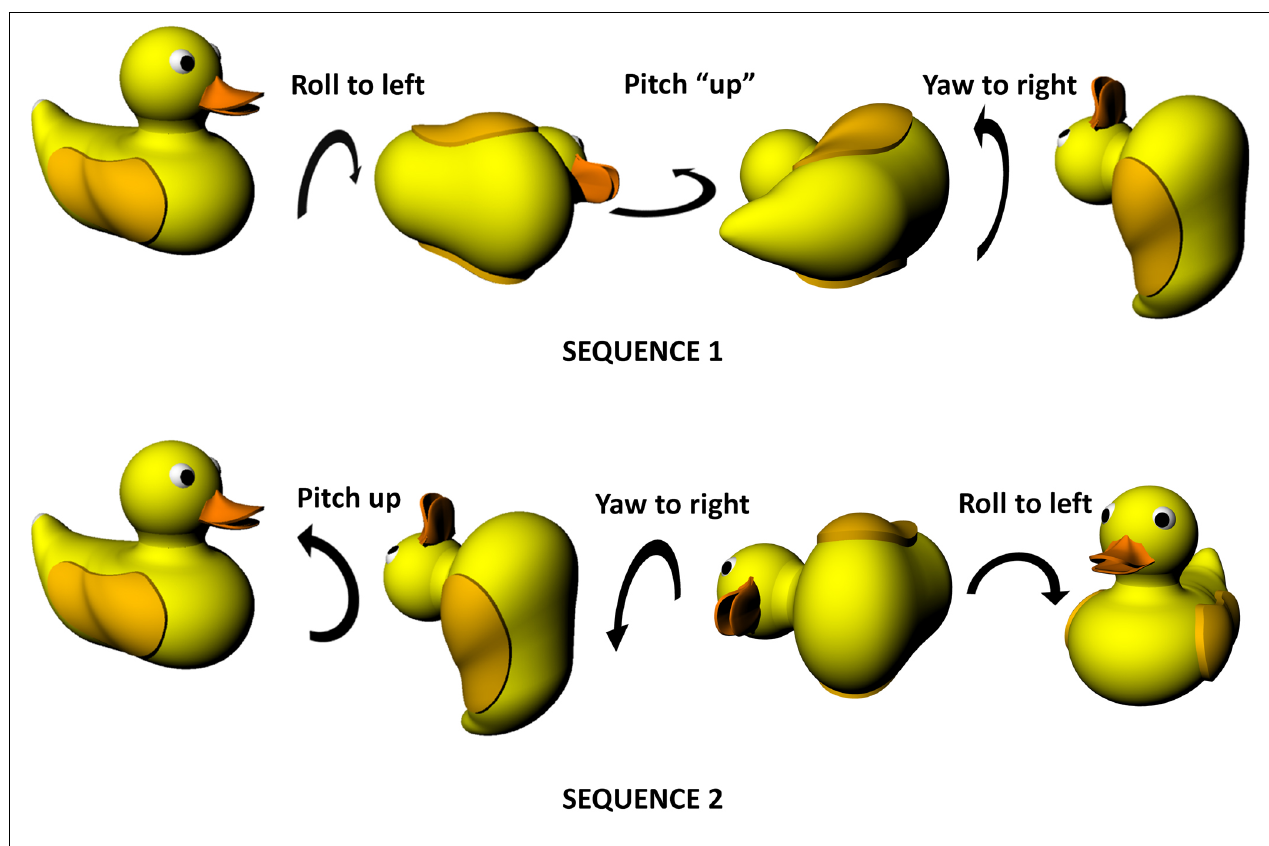
FIGURE 1 | Non-commutativity of rotations in three dimensions, showing that the same set of rotations (a pitch, a roll and a yaw) result in differing outcomes depending on the order in which they occur. Note that the rotations are expressed in an